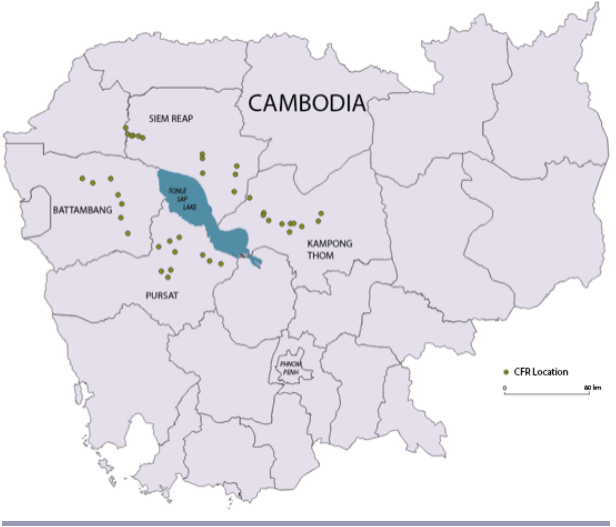
Fig. 2 . Map of Community Fish Refuge sites (green dots) within the Tonle Sap Floodplain. The Tonle Sap Lake is represented in blue, dark gray lines represent provincial boundaries, and provinces included within the study and the capital of Phnom Penh are